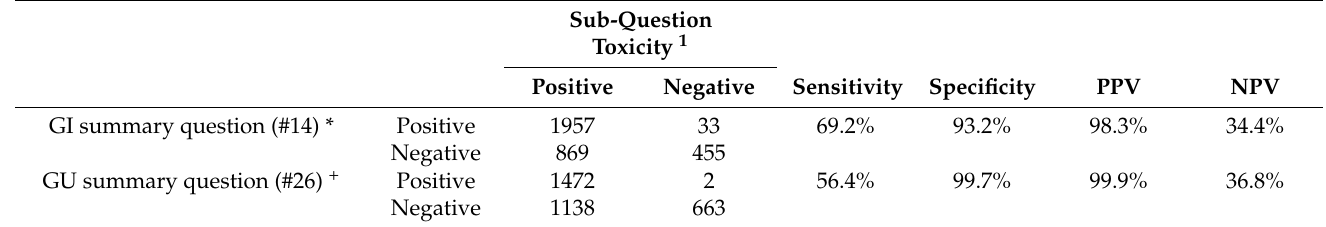
Table 3. Sensitivity and specificity of summary questions.